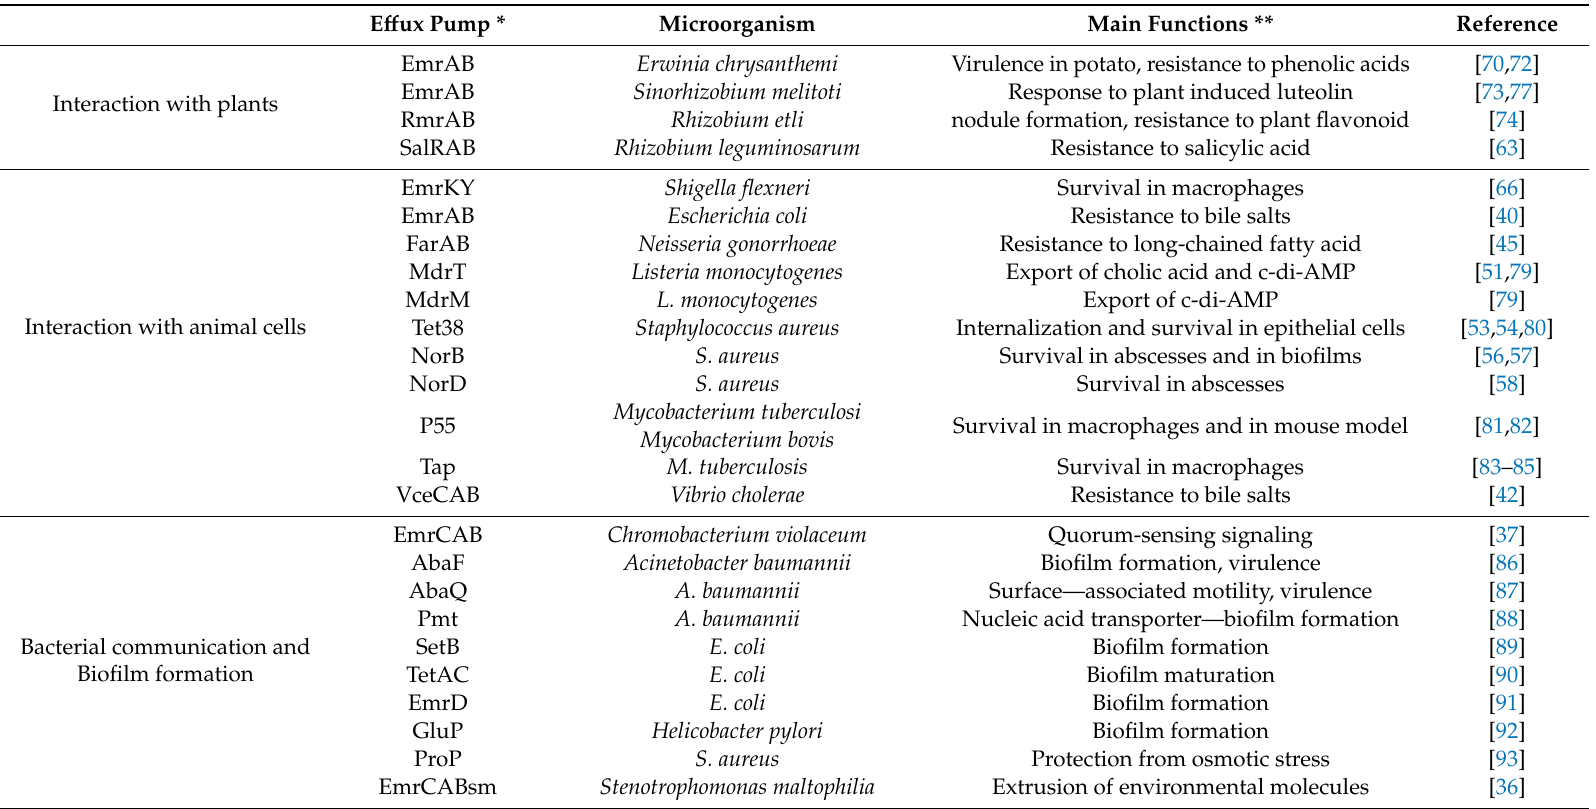
Table 1. E ffl ux pumps of the MFS family involved in interactions with plant, animal, and bacterial